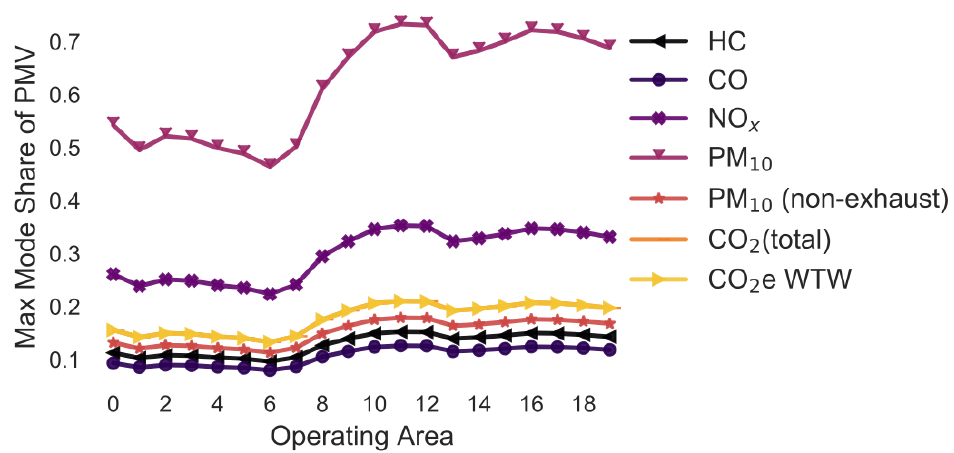
Figure 5. Maximum mode share of customers who can pick up a parcel by car (varying street type) (note: CO 2 (total) and CO 2 e WTW are the same).